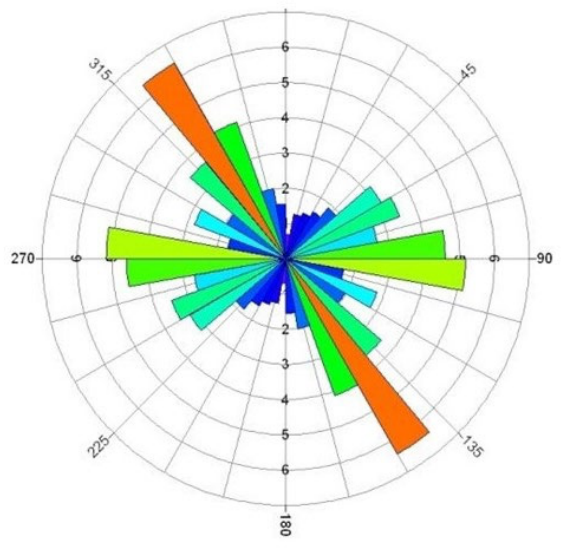
Figure 7. Rose diagram showing the distribution of fault trends at the broader area of Kardia mine. The highest percentage of all faults’ lineation (>150 faults segments) by length is following an NW–SE direction in the broader area of the mine. The total length of the faults is 224 km, the average bin population is 51.81, and the standard deviation of the bin population is